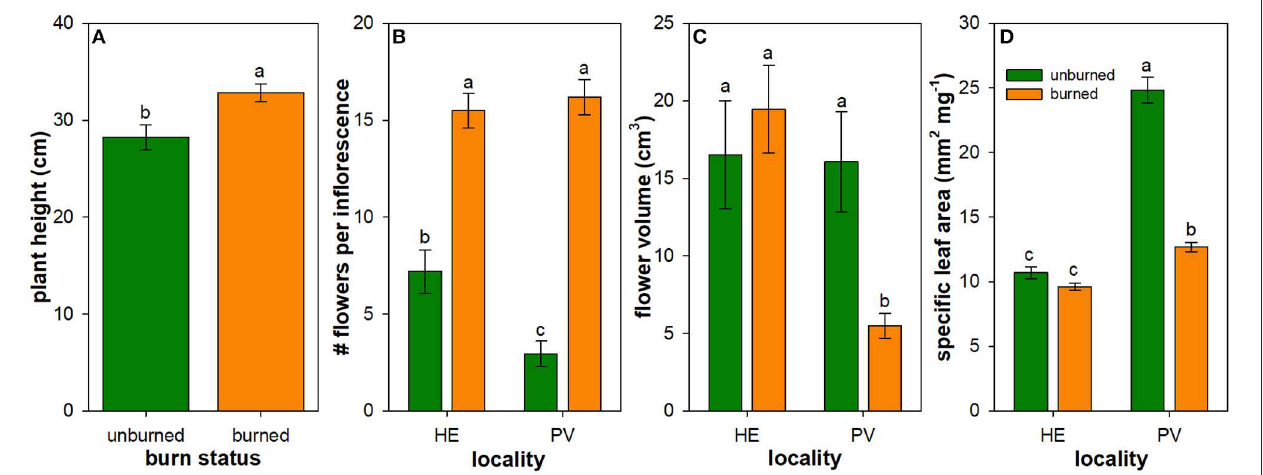
FIGURE 3 | Influence of wildfire on plant traits: plant height (A) , number of flowers per inflorescence (B) , flower volume (C) , and specific leaf area (D) . Least square mean ( ± 1SE) plant traits across all individuals of all species measured in burned (orange) and unburned (green) plots. Back-transformed least square means are shown for number of flowers per inflorescence, flower volume, and specific leaf area (SLA). Only the main effect of burn status is illustrated in panel A due to the lack of interactive effect between locality and burn status on plant height ( Table 3 ). Letters represent significant differences in means at α = 0.05. N = 16–18 unburned plots per locality; N = 36 burned plots (mixed-severity and high-severity fires) per